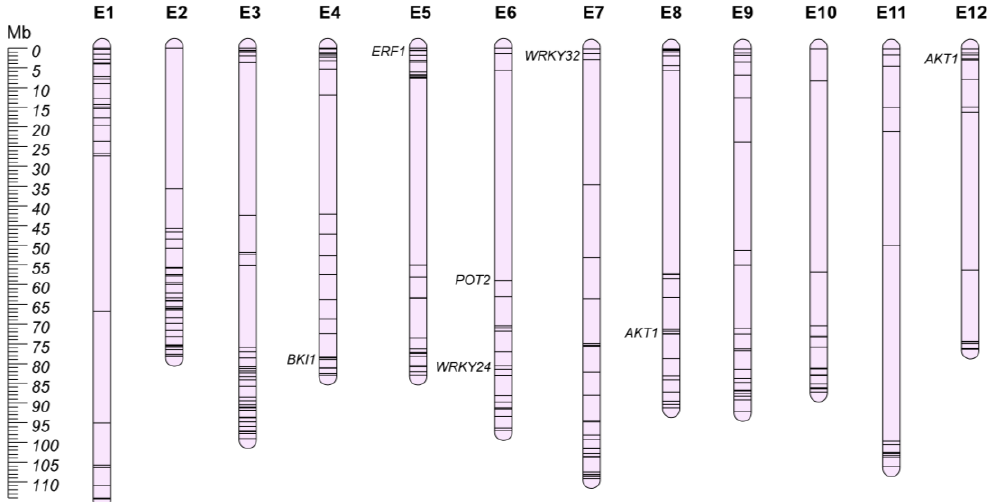
Figure 7. Abiotic resistance chromosome map (E1 – E12). Main candidate genes are reported in italics, while information about the other candidates (represented by bars on the chromosomes) is shown in Table S3.